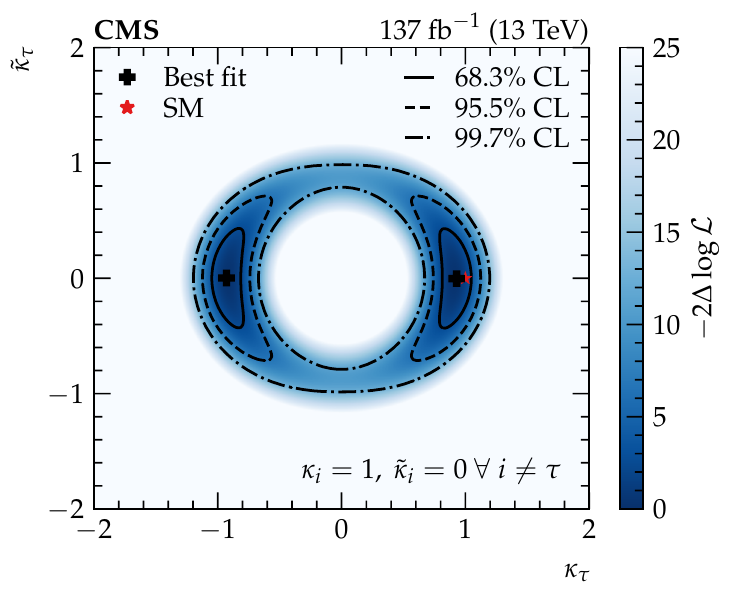
) and CP -odd ( ) t Yukawa couplings. κ e τ τ